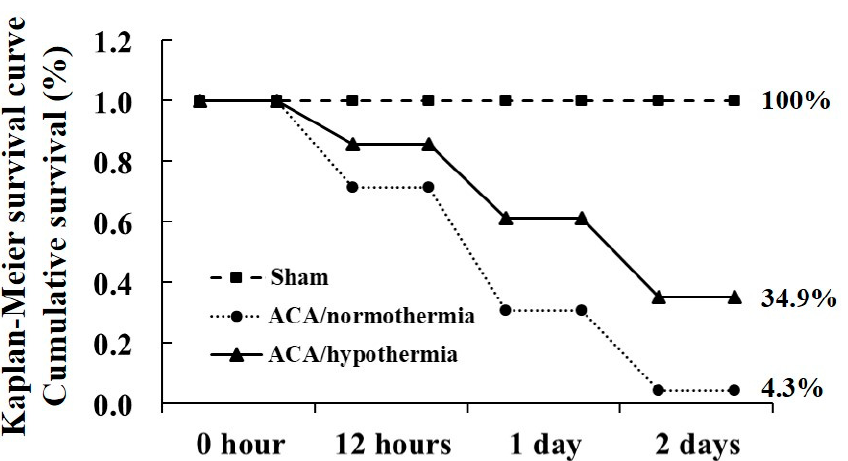
Figure 1. Cumulative survival rate (log-rank test, p < 0.05) in the sham, ACA/normothermia, and ACA/hypothermia groups using Kaplan–Meier analysis for 2 days after asphyxial cardiac arrest (ACA). The ACA/hypothermia group shows a higher survival rate than the ACA/normothermia group ( n = 5 and 7 in sham and ACA group, respectively).